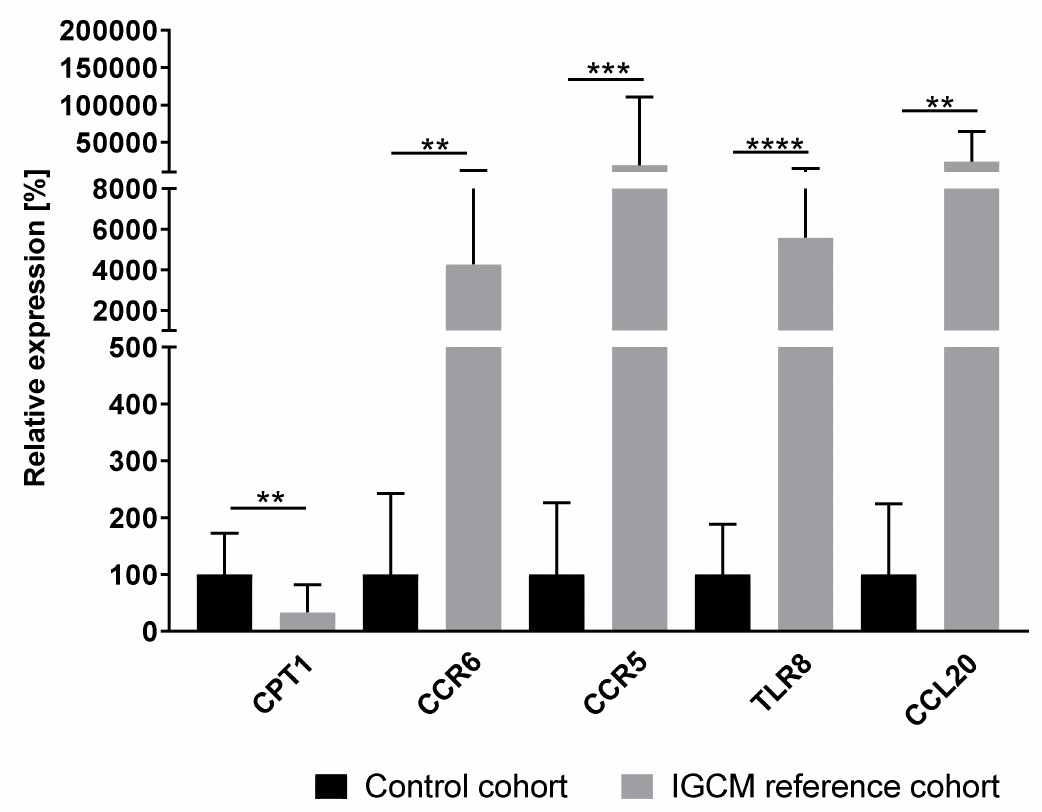
Figure 2. Gene-expression profiles for IGCM patients ( n = 26) in relation to inflammation-negative patients / control cohort ( n = 23). The figure shows a distinct gene-expression pattern with high statistical significance, asderivedfromtheunpaired t -test. P -valuesaredenotedbyasterisks: ** p ≤ 0.01, *** p ≤ 0.001, **** p ≤